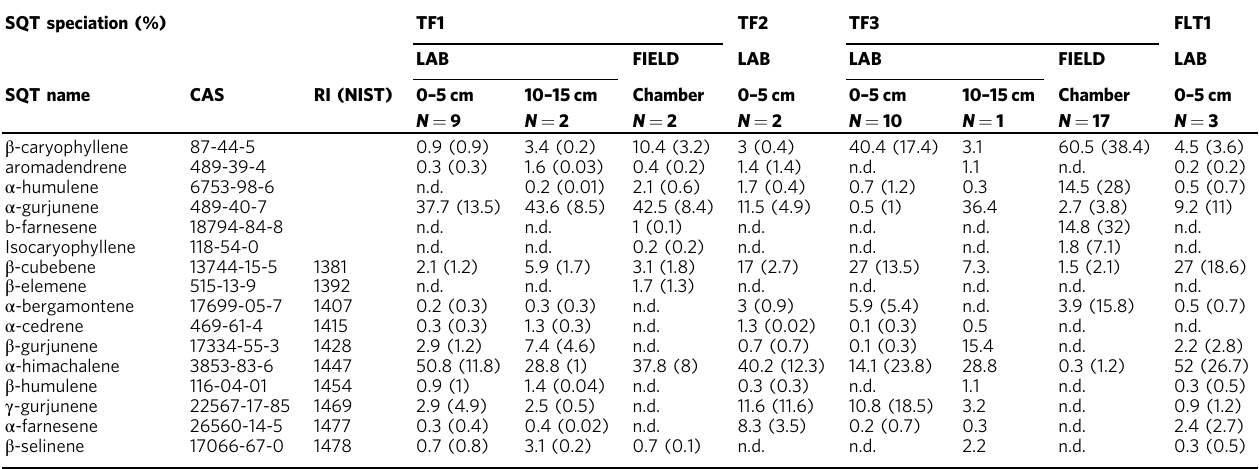
Table 1 Chemical speciation (%) of SQT emissions from Amazonian soils SQT speciation (%) TF1